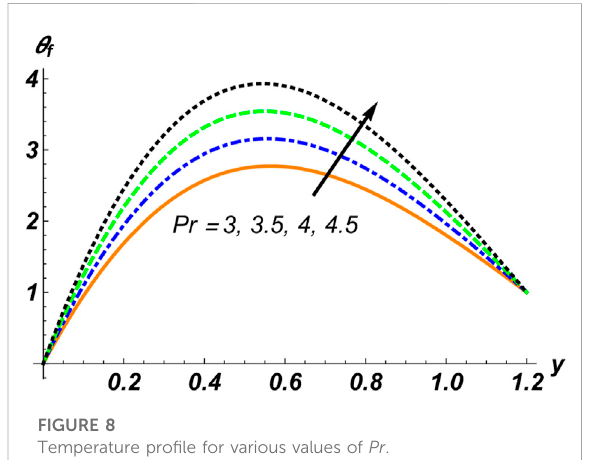
Velocity pro fi le for various values of E 1